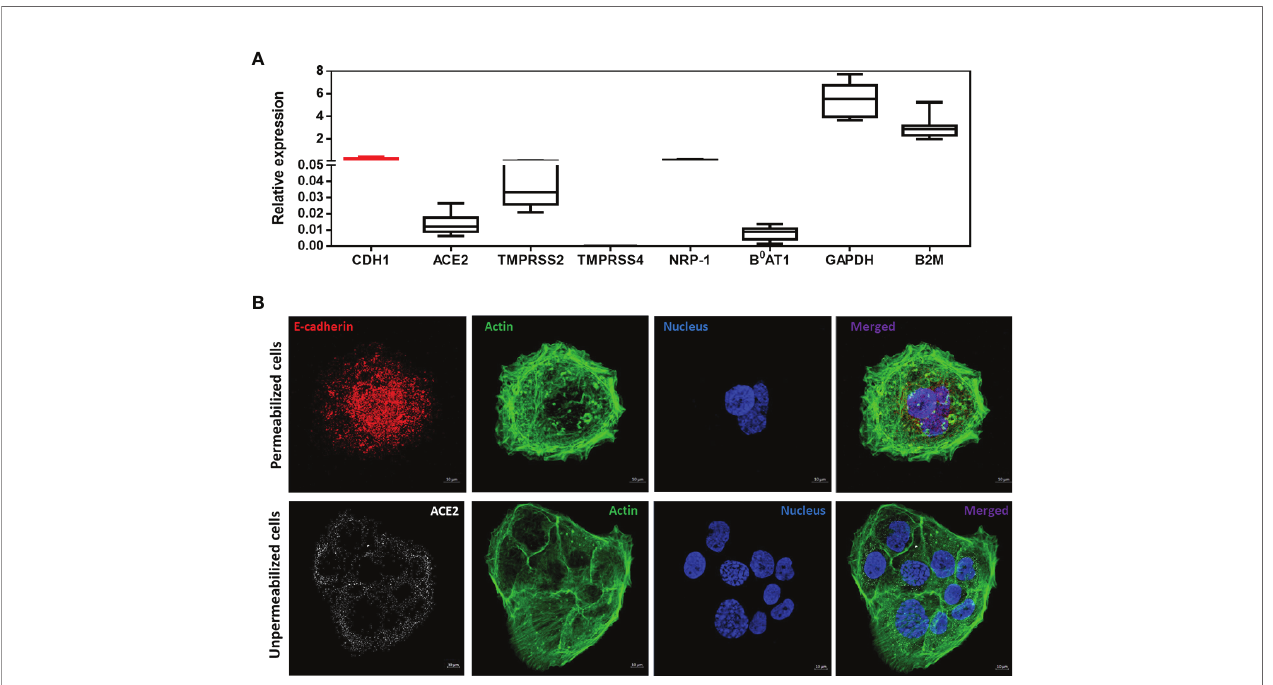
FIGURE 1 | (A) Expression of CDH1/E-Cad, ACE2, TMPRSS2, TMPRSS4, NRP-1, B 0 AT1, GAPDH and B2M mRNA in virus-free Caco-2 cells. The results (n=8) are expressed as RE where RE = 2 ( − D CT) . (B) Confocal microscope analysis of E-cad, ACE2 and actin expression on Caco-2 cells. The experiment was performed using cells permeabilized with 0.1% Triton X-100 (upper panel) and unpermeabilized cells (lower